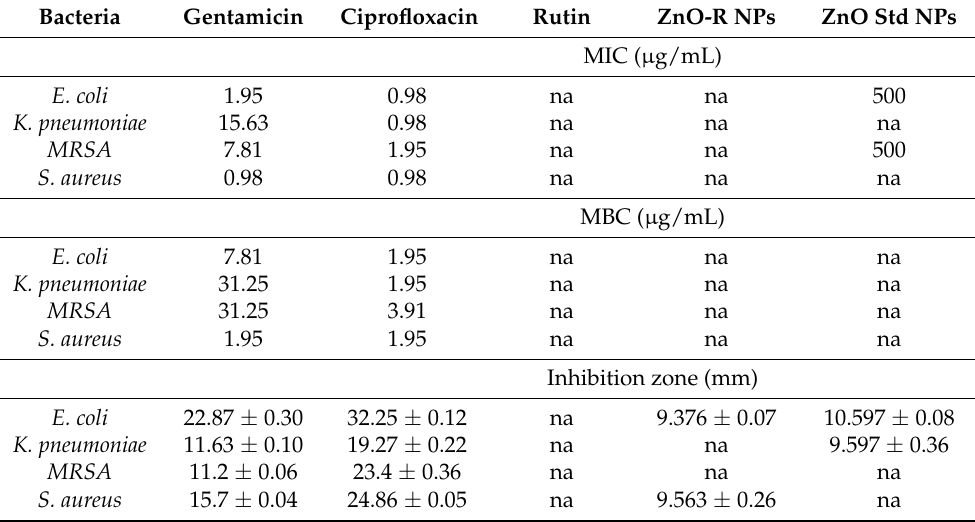
Table 1. MIC, MBC and the zone of inhibition of ZnO Std NPs, ZnO-R NPs and rutin. Bacteria